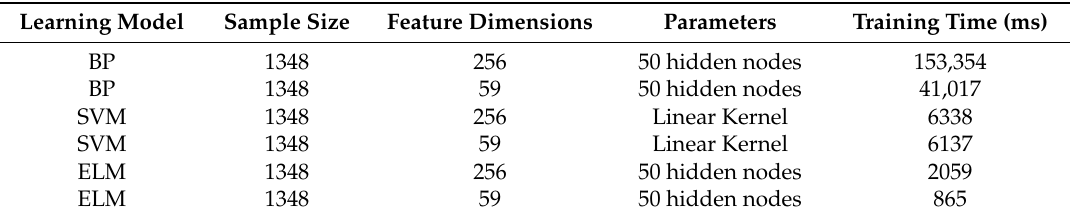
Table 3. Comparison of training time among ELM and other models.